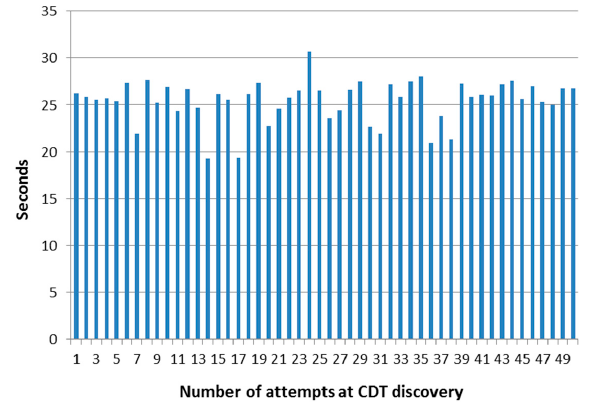
Figure 13. Time measurements for CDT discovery.